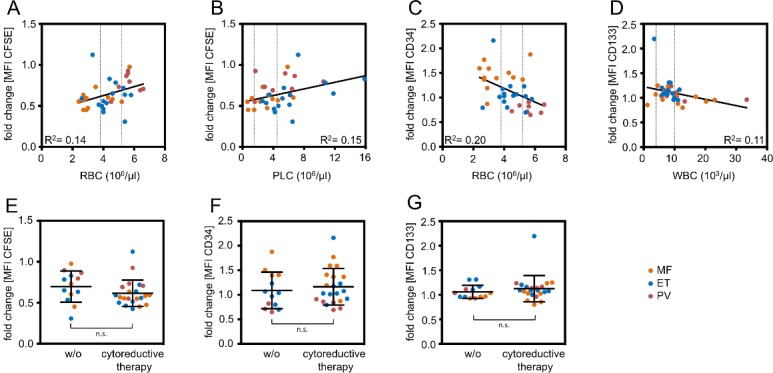
Moderate association of stimulatory effects of serum with corresponding blood counts.Mean fluorescence intensities (MFI) were normalized to healthy controls and fold changes were correlated with clinical parameters. (A) Serum taken from patients with low red blood cell (RBC) counts had in tendency higher stimulatory effect on proliferation of HPCs. MFI of residual CFSE staining was normalized by the mean of the healthy control. (B) Proliferation of HPCs was higher in serum with lower platelet counts (PLC). (C) Serum of patients with low RBC counts supported maintenance of CD34 expression better than serum of patients with high RBC counts. (D) White blood counts (WBC) revealed moderate anti-correlation with maintenance of CD133 expression in HPCs upon culture with corresponding serum samples. (E-G) Cytoreductive therapy did not impact on the stimulatory effect of patient serum with regard to (E) proliferation, (F) CD34 expression, and (G) CD133 expression (mean ± standard deviation; n.s. = not significant).